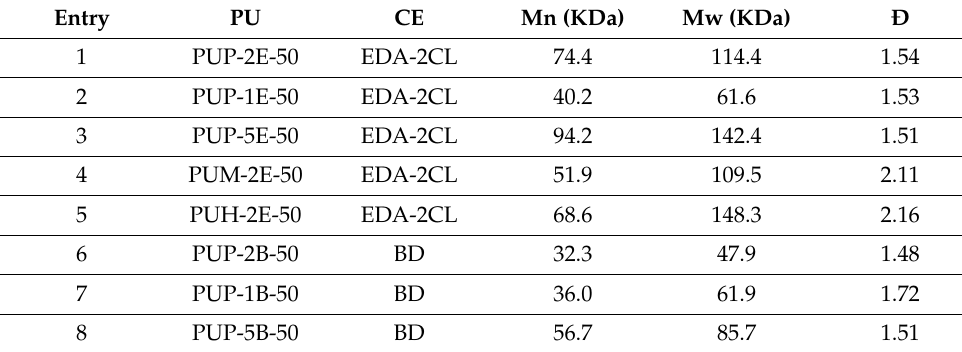
Table 1. SEC results for the synthetized